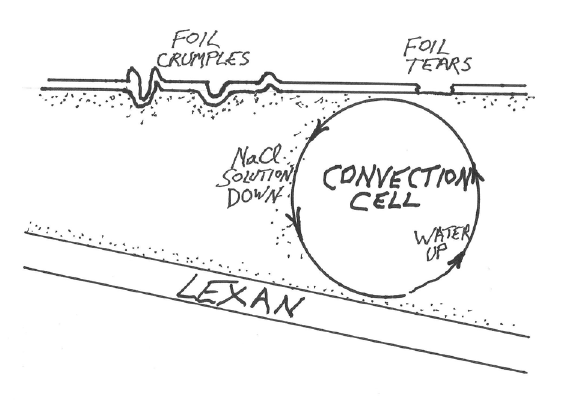
Fig. 6: Damage to floating foil caused by